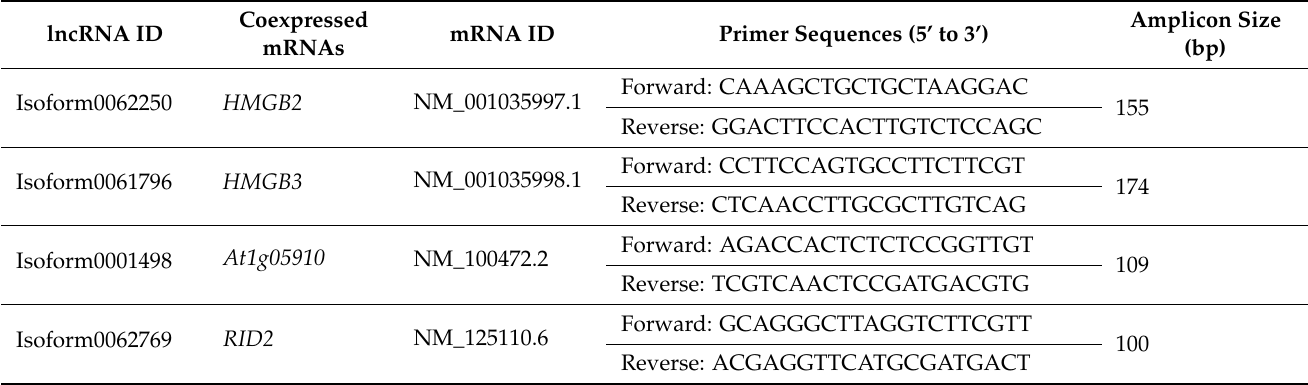
Table 1. Primer sequences used in qRT-PCR